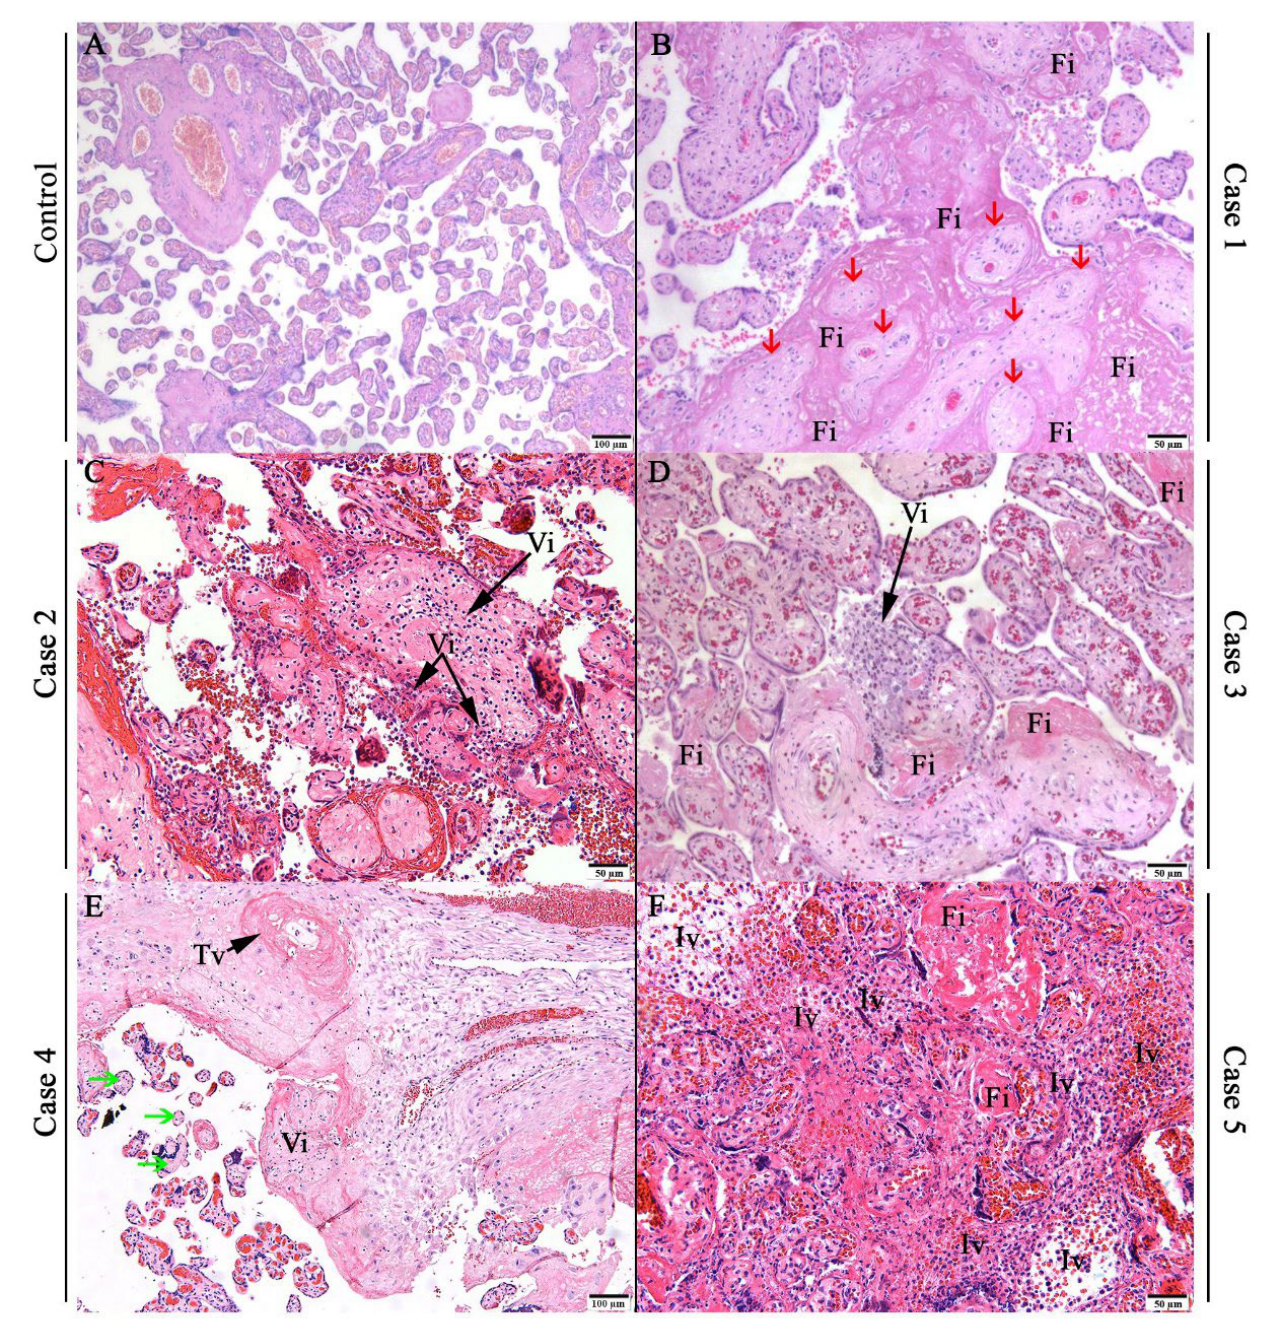
Figure 2. Histopathological changes in SARS-CoV-2-infected placentas. ( A ) Prepandemic control placenta with regular aspect. ( B – F ) Representative microphotographs of SARS-CoV-2-infected placentas. Fibrin deposition (Fi); trophoblastic necrosis (red arrow); villitis (Vi); chronic villitis (Vi); avascular villi (green arrow); decidual vessel thrombosis (Tv); and intervillitis (Iv).